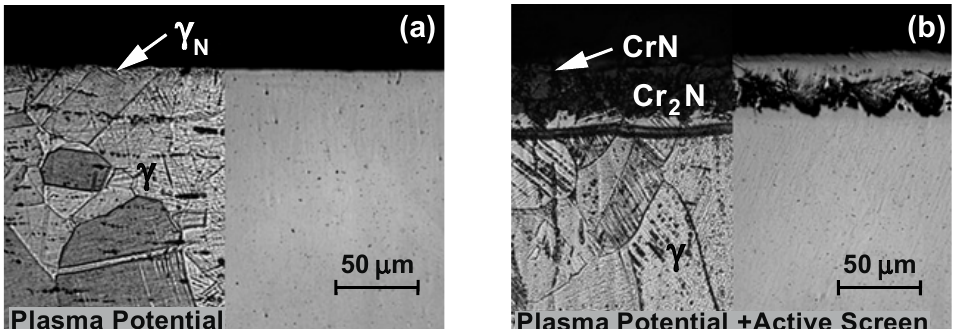
Figure 6. Microstructure of nitrided layers on the 316L steel substrate, temperature T = 490 °C, time t = 14 h; ( a ) plasma potential, ( b ) plasma potential + active screen.